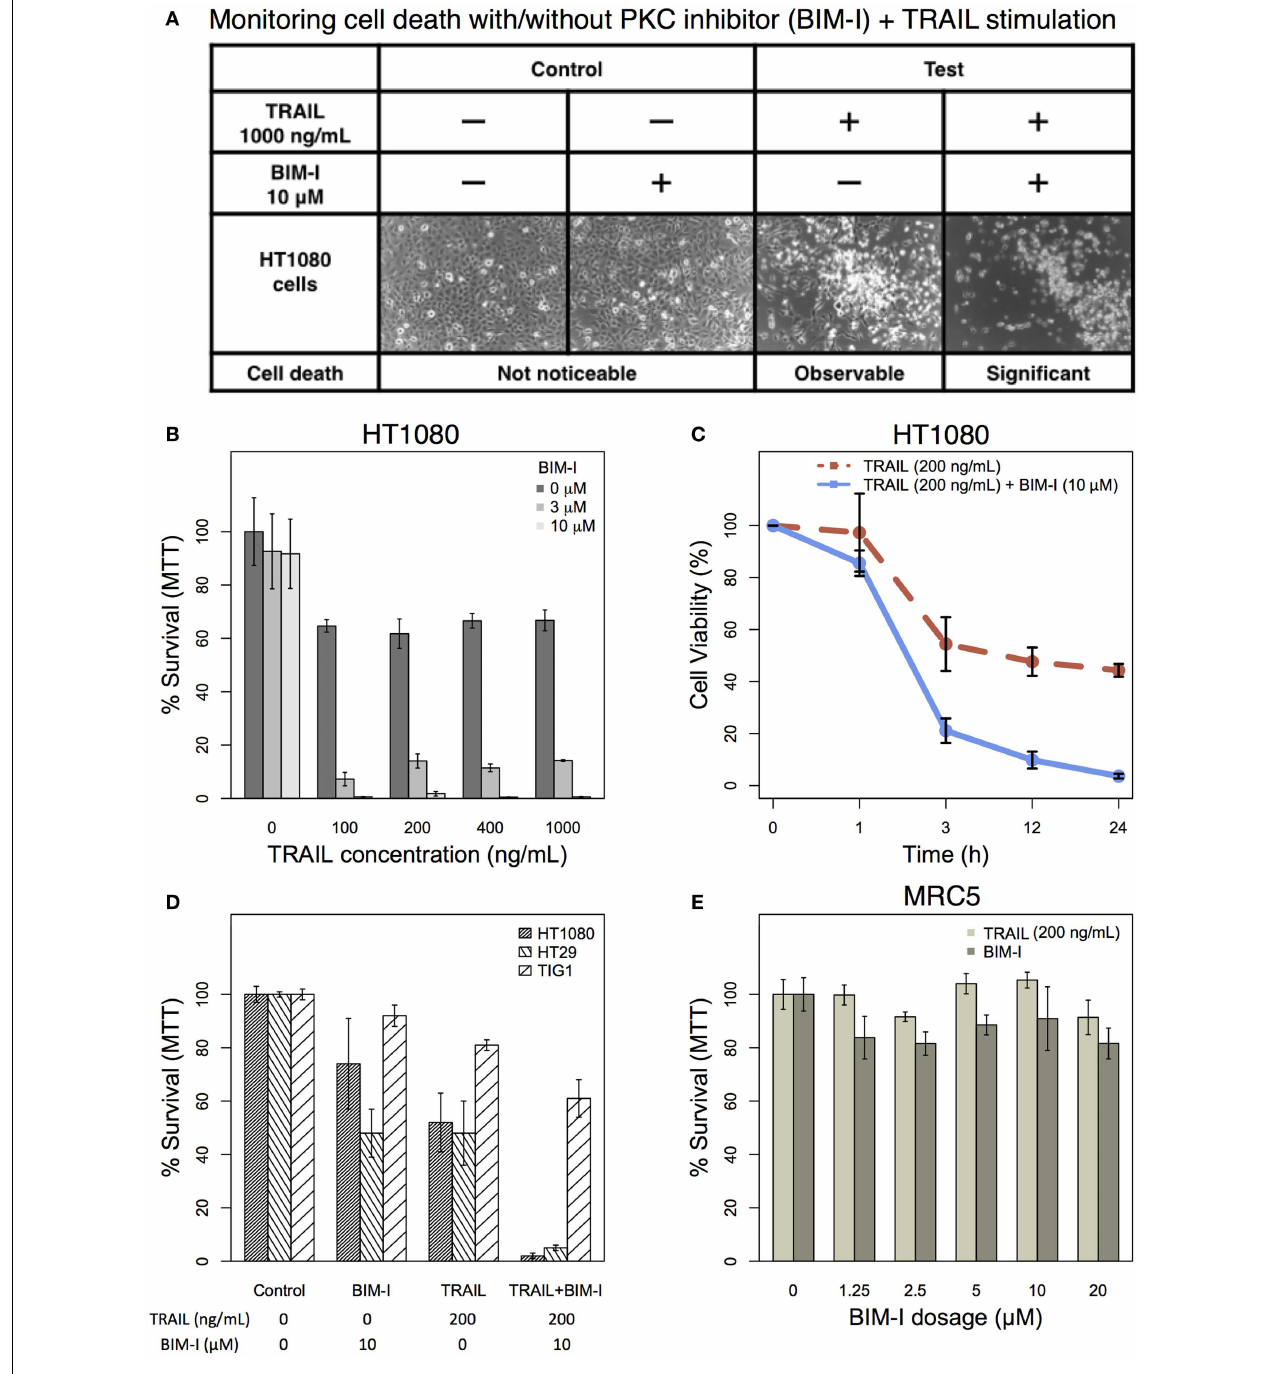
treatment (TRAIL: 200ng/mL, BIM-I: 10 µ M). (D) Cell survival (MTT assay) rates of HT1080 (1 × 10 5 ), HT29 (1.5 × 10 5 ) cancer cells, andTIG-1 (2 × 10 5 ) normal cells were observed 24h after treatment in the presence ofTRAIL (200ng/mL) or BIM-I (10 µ M), or both, compared to unstimulated cells (control). (E) BIM-I dosage-dependent (0, 1.25, 2.5, 5, 10, 20 µ M) cell survival rates of MRC-5 (0.5 × 10 5 ) normal cells after TRAIL stimulation (200ng/mL) were obtained through MTT assay after 24h. Average cell viability is shown in percentage for n = 3 independent experiments. Error bars indicate mean values ±